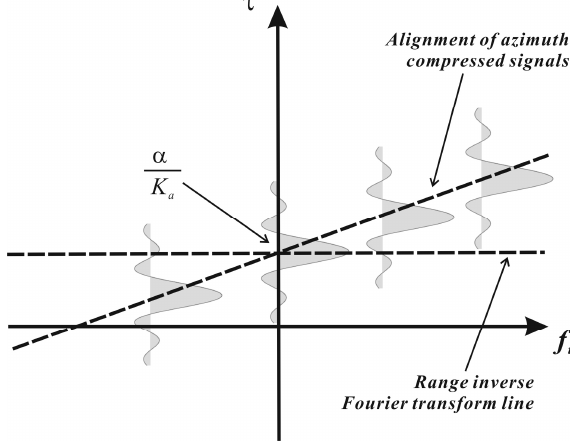
Figure 2. Schematic of the effect of residual phase Φ 2 ( f , f τ ) in the range frequency-azimuth time domain. The coupling between the range and azimuth frequencies projects the azimuth-compressed signals on a slanted line rather than a horizontal line in the range frequency-azimuth time domain. The slope largely depends on α (or v y ); consequently, the ground object with large range speed suffers a significant distortion.